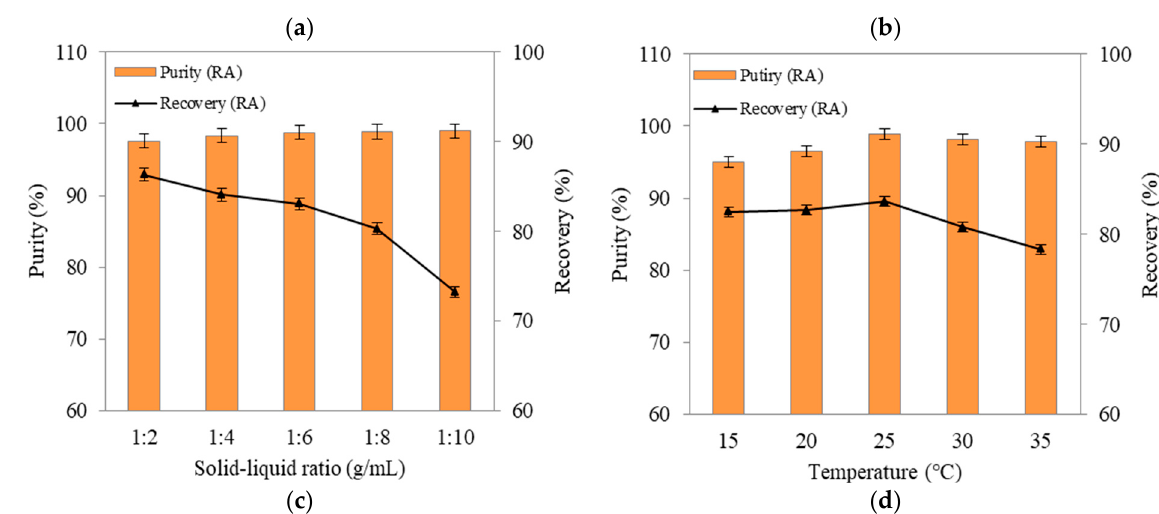
Figure 3. Effect of ( a ) MeOH concentration (16 h, 1:4 of the solid-liquid ratio, and 25 ◦ C), ( b ) recrystallization time (90% of methanol concentration, 1:4 of the solid-liquid ratio, and 25 ◦ C), ( c ) solid-liquid ratio (90% of methanol concentration, 16 h, and 25 ◦ C), and ( d ) temperature (90% of methanol concentration, 16 h, and 1:4 of the solid-liquid ratio) on purity and recovery of